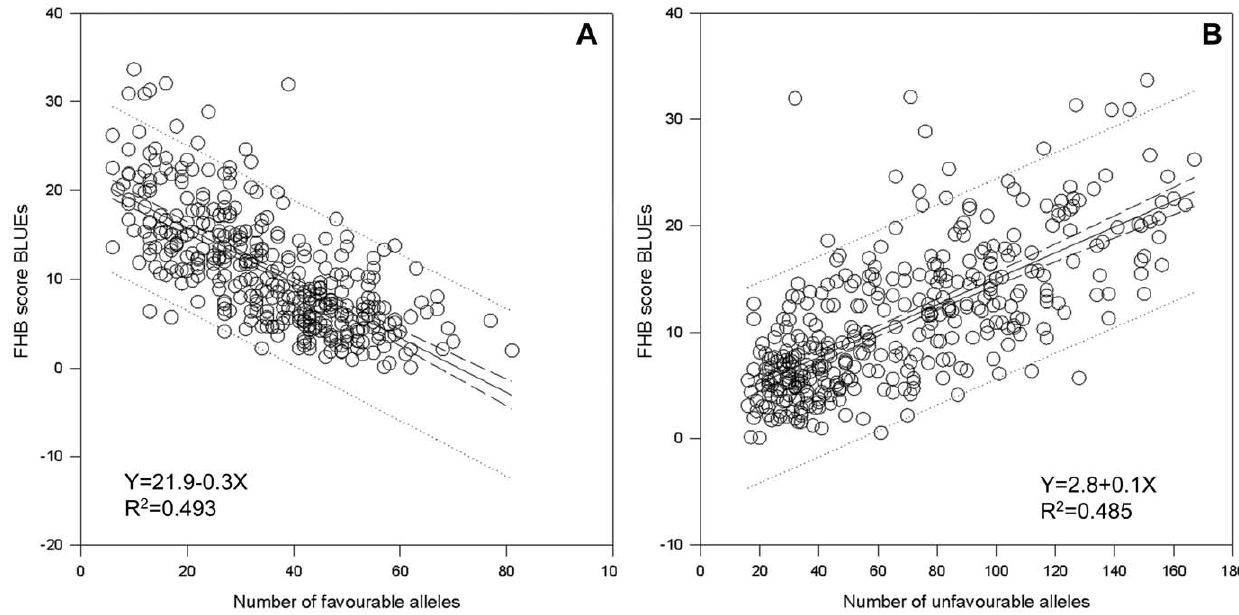
Figure 7. Effect of (A) favourable and (B) unfavourable FHB alleles. Linear regression resulted in a relationship of FHB-BLUEs score and number of favourable and number of unfavourable alleles in 372 wheat varieties.